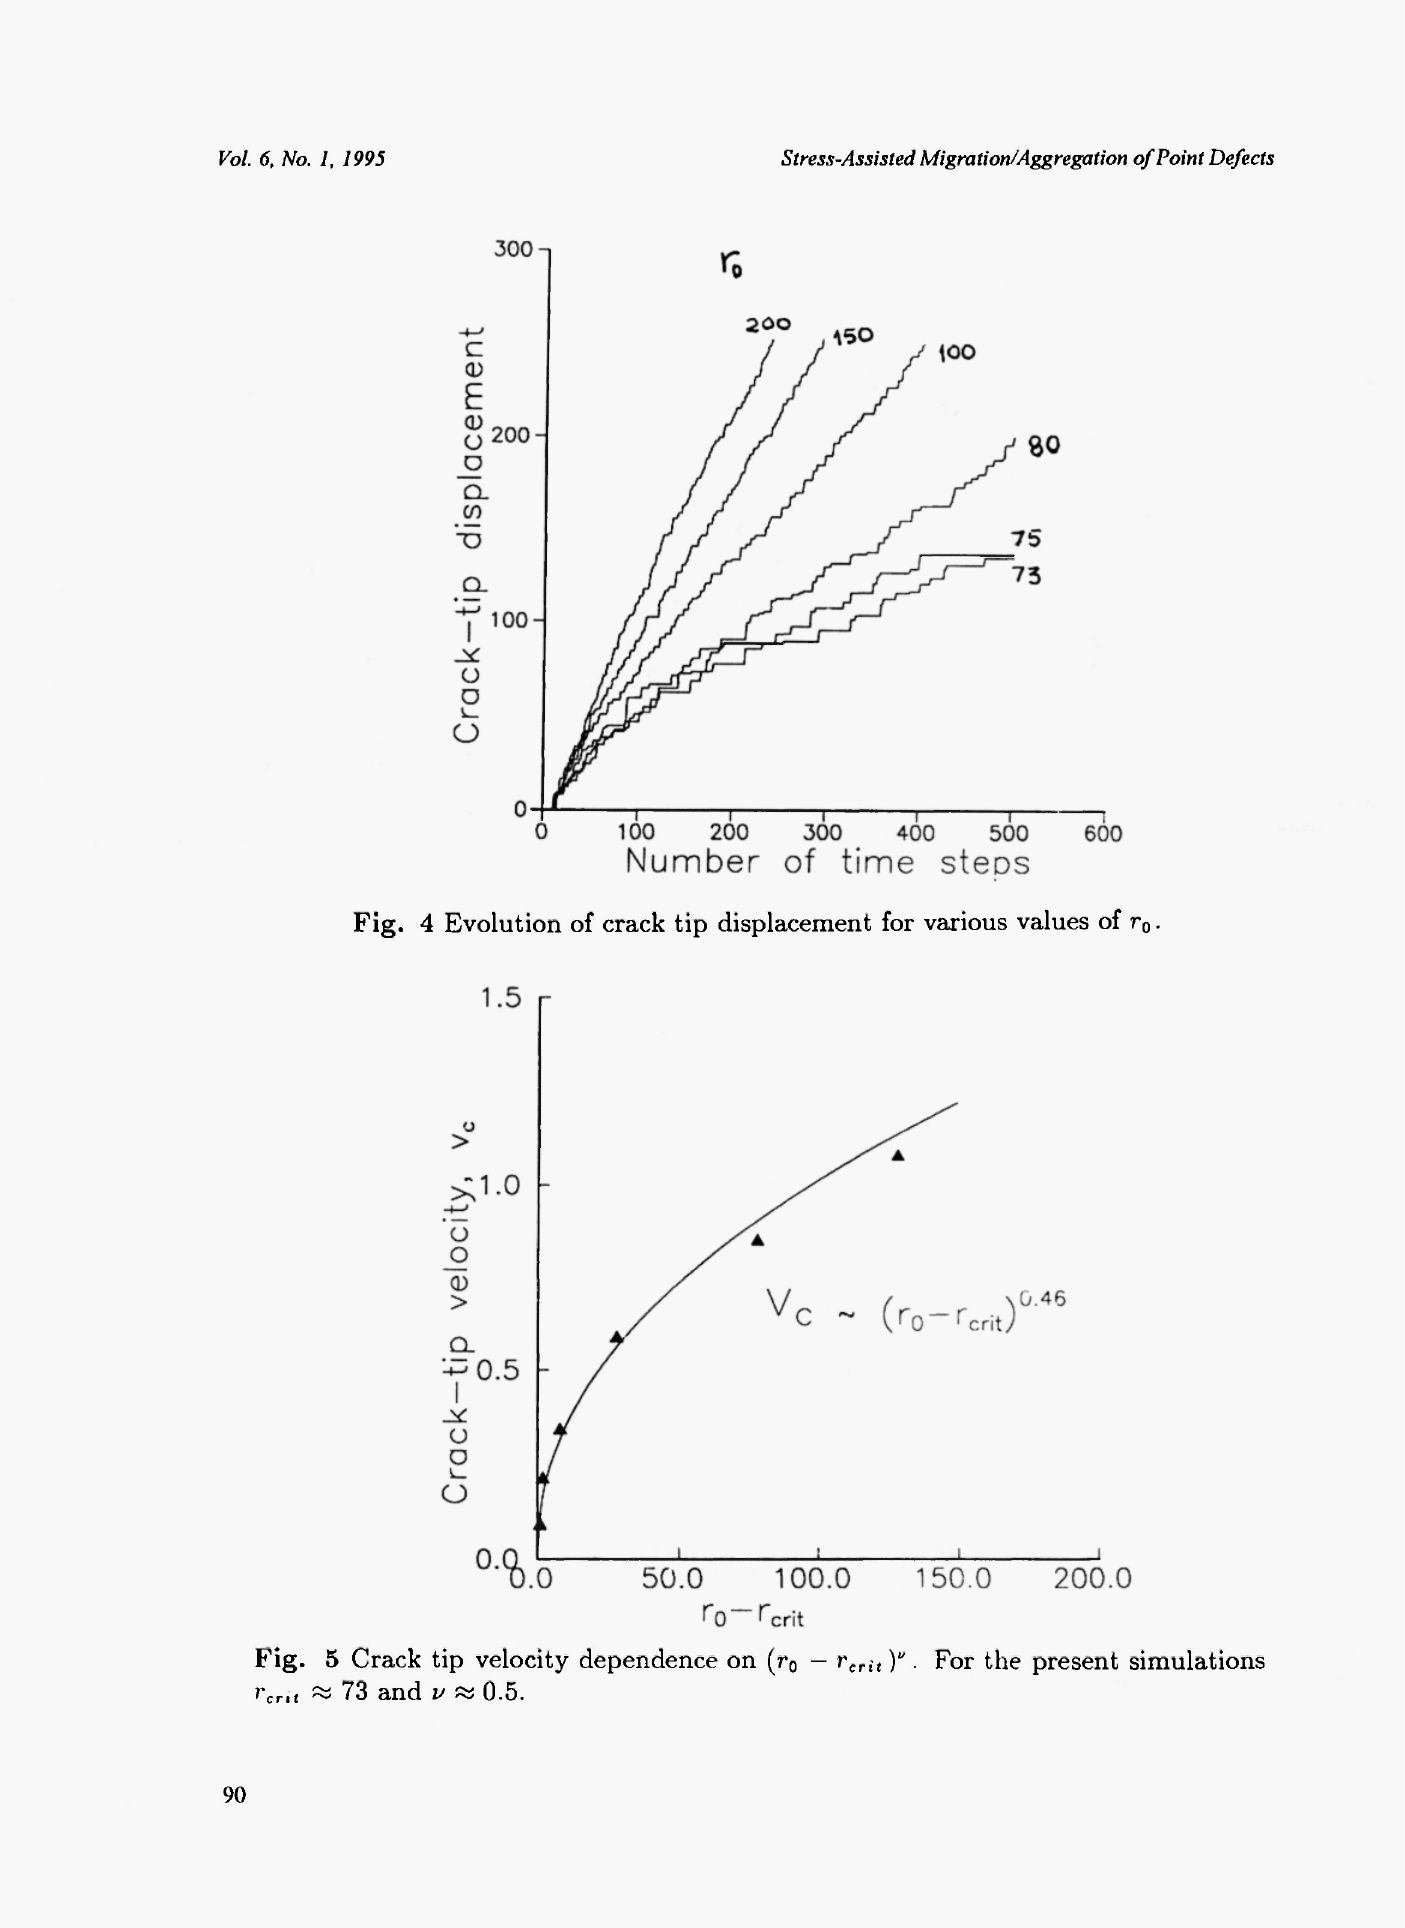
For the present c r i t ) ".